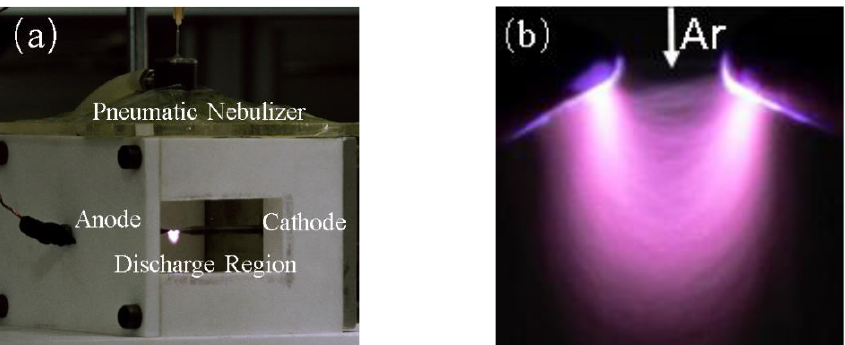
Figure 3. ( a ) Nebulization plasma reactor; ( b ) image of nebulized discharge. (Ar flow rate: 1.68 L/min, discharge gap: 2 mm, applied voltage: 5.6 kV).